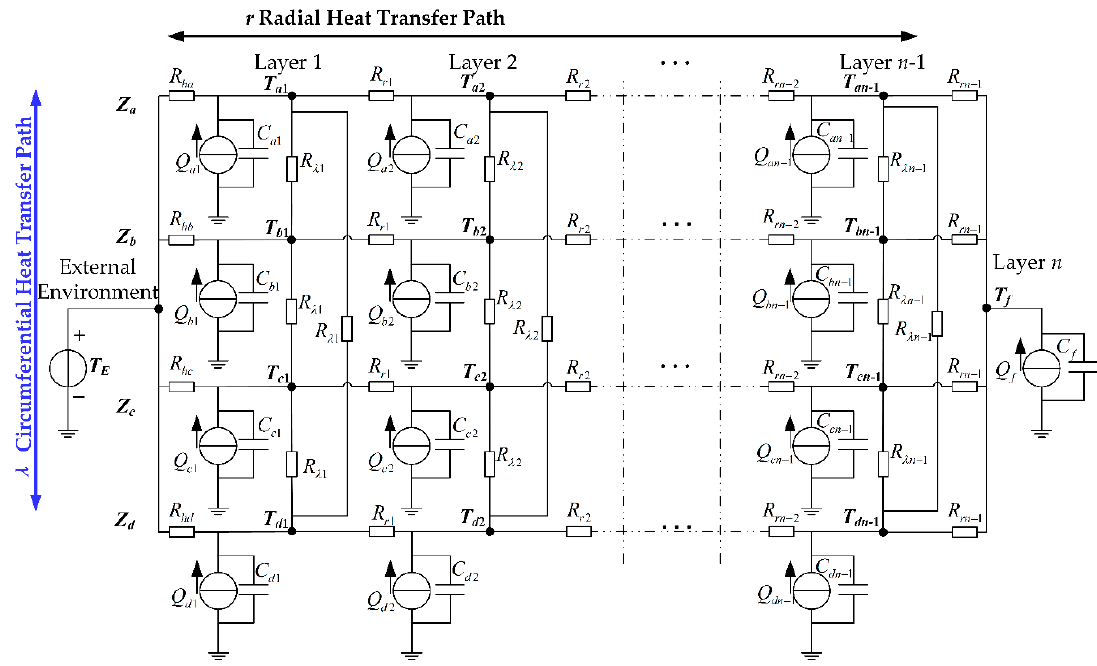
Figure 3. ETN of the overhead transmission lines considering radial and circumferential heat transfer paths. transfer